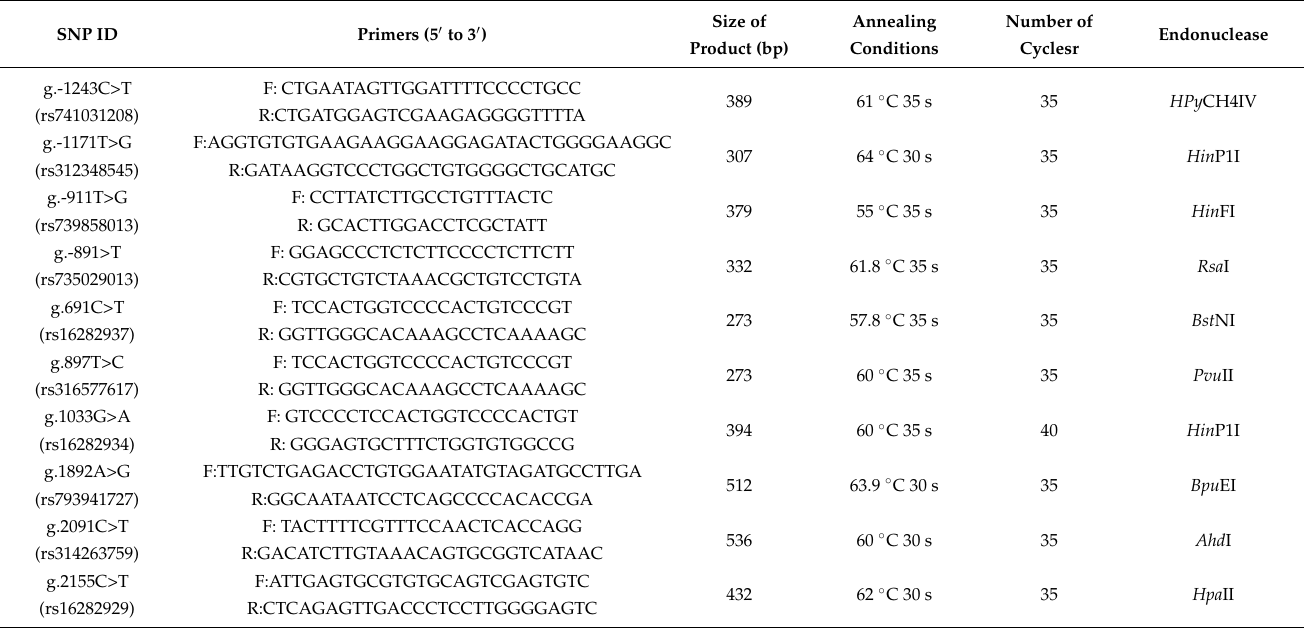
Table 1. Primers used to amplify the SNPs in the TCF21